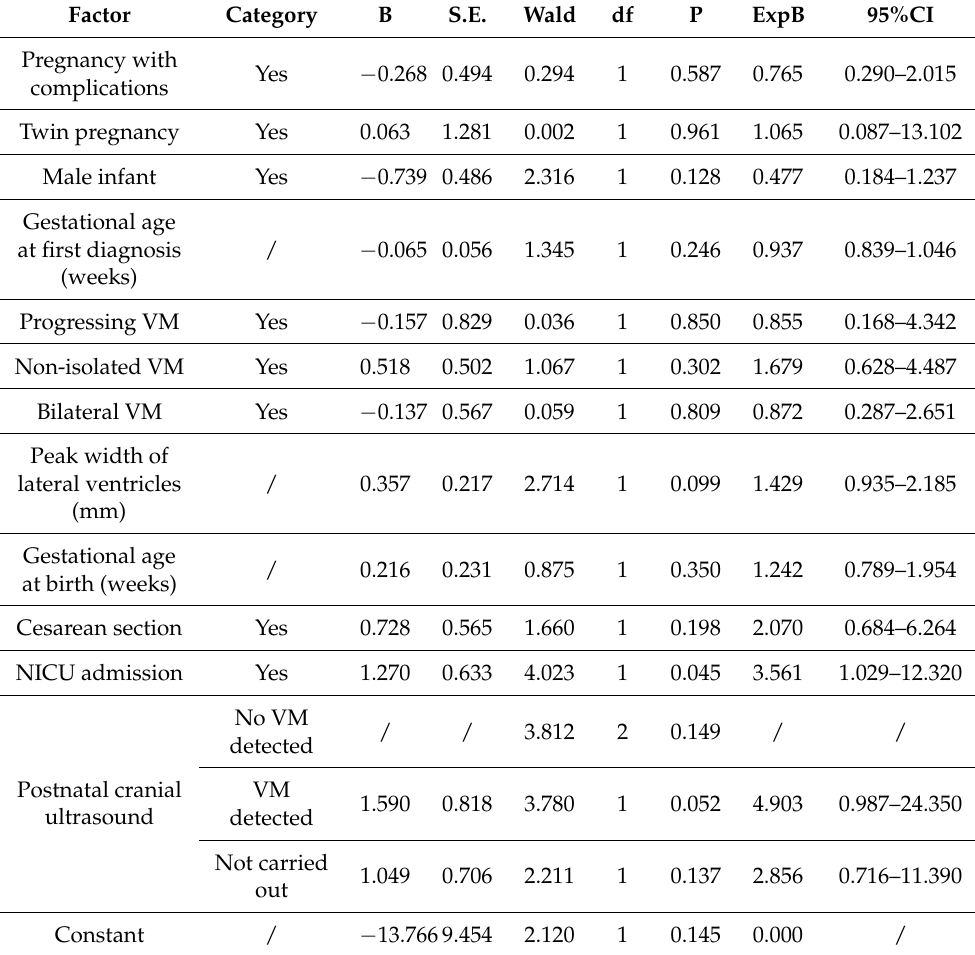
Table 4. Binary logistic regression analysis of long-term prognosis of live birth VM